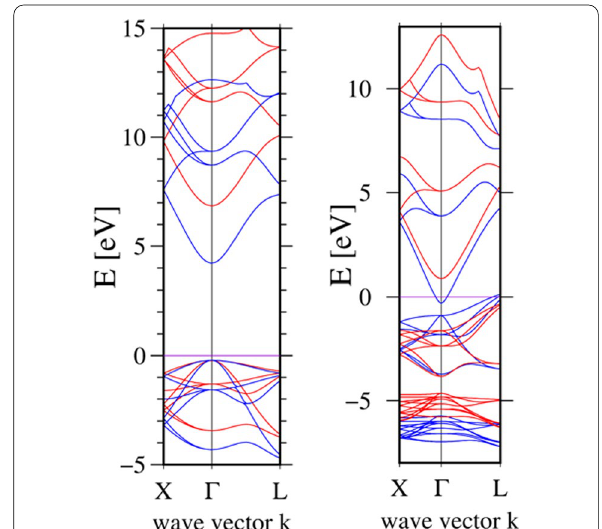
Fig. 5 (Color online) Band structure obtained from VAPS for PBE (blue) exchange–correlation functional and GGA-1/2 (red) correction for MgO (left) and CdO